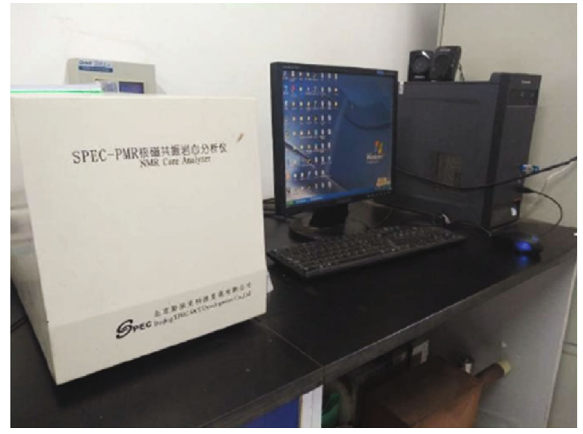
Figure 3: SPEC-023 NMR